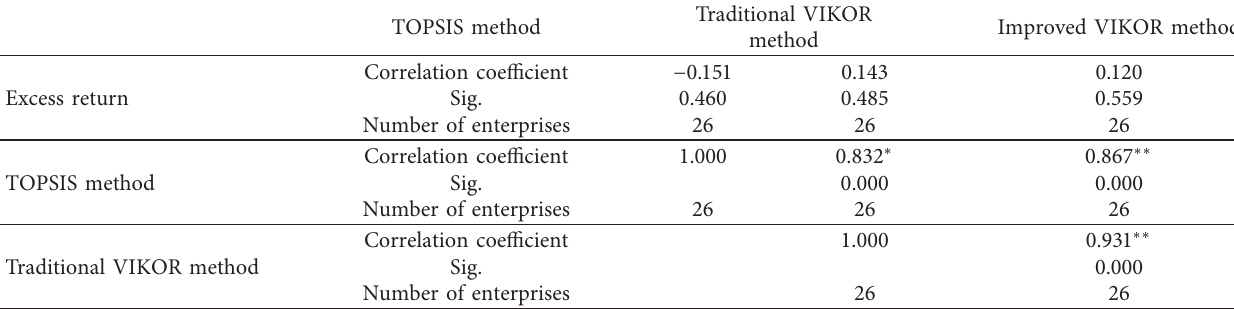
Table 6: The correlation between the 2016 evaluation results and the excess return rate